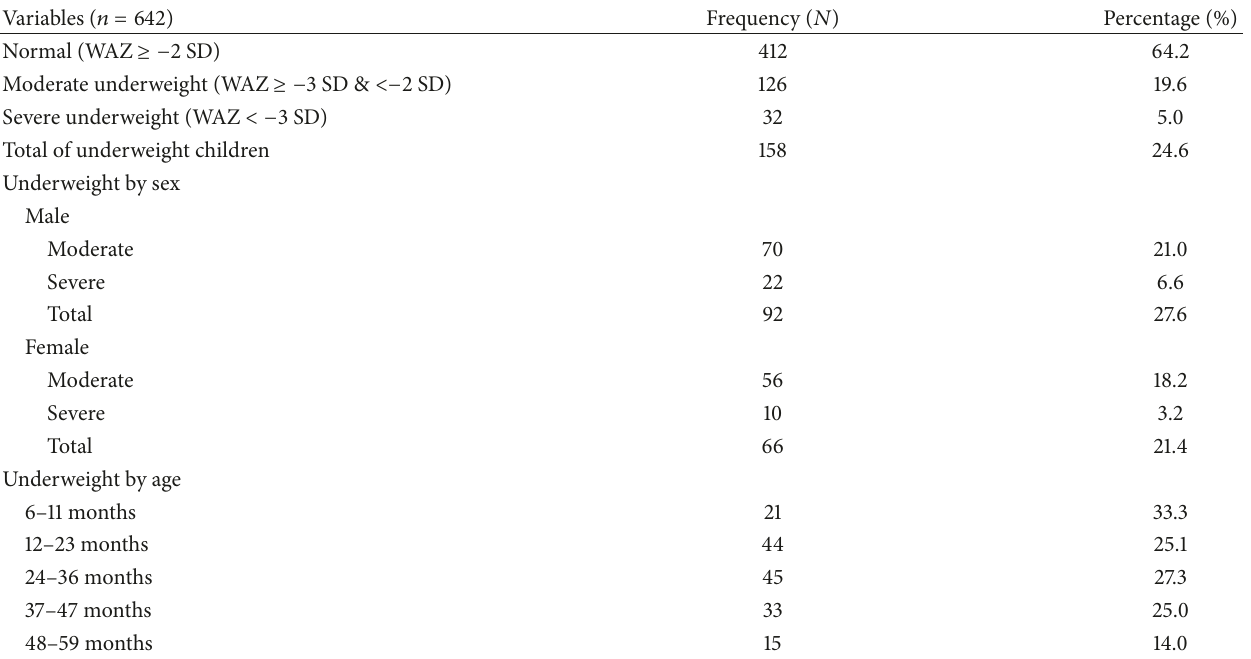
Table 2: Prevalence of underweight among children aged 6–59 months in Wolaita Sodo town, southern Ethiopia, 2016. Variables (𝑛 = 642) Frequency ( 𝑁 ) Percentage (%) Normal (WAZ ≥ − 2 SD) 412 Moderate underweight (WAZ ≥ − 3 SD & <− 2